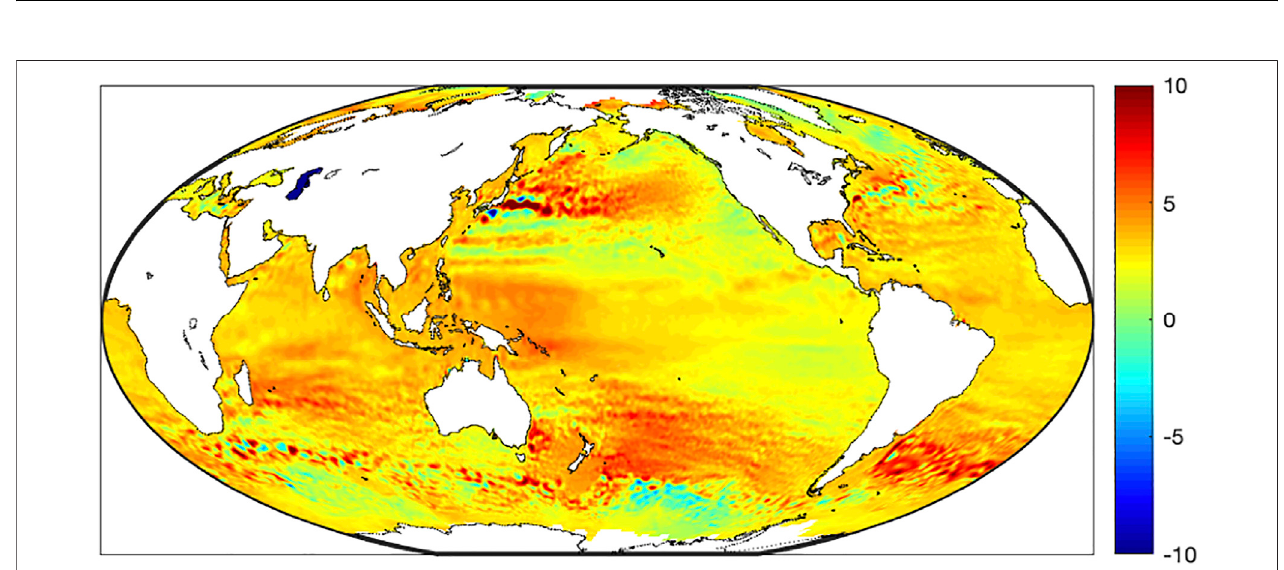
FIGURE 7 | Mean sea level trend (mm/y; January 1993 – October 2019) from multi-mission satellite altimetry (data source: AVISO).